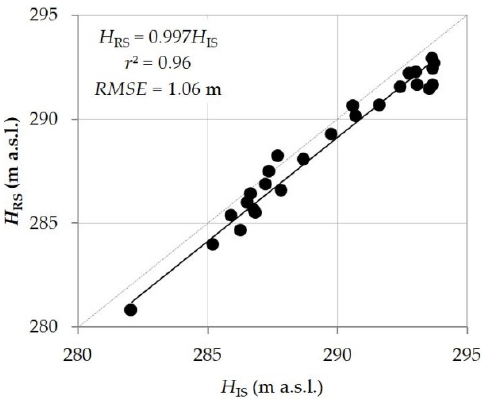
Figure 3. Daily water levels measured in situ, H IS (m a.s.l.), from 1 January to 31 December 2015. A linear interpolation curve is superimposed–imposed (continuous line).